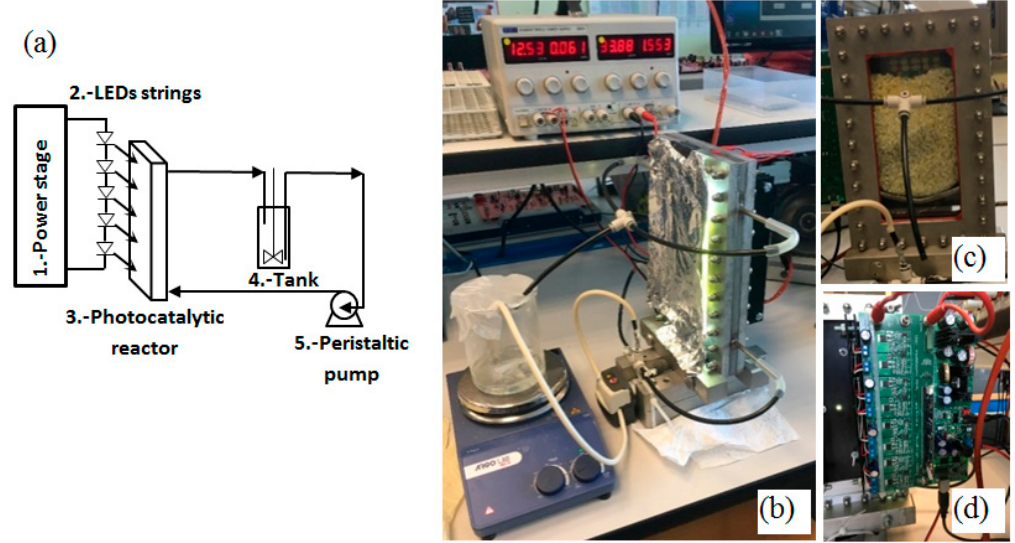
Figure 1. ( a ) Scheme of experimental system; ( b ) Experimental setup; ( c ) details of flat-plate reactor filled with N-TiO 2 / PS catalyst (front view); ( d ) DC / DC single ended primary inductor converter (SEPIC) regulator feeding 8 parallel strings, each one made by 10 visible light LEDs in series.